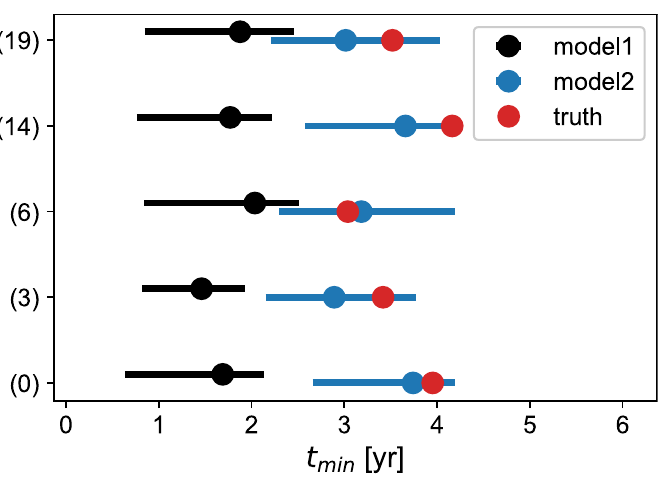
Fig 8. Monte-Carlo estimates of the regrowth time with an extra point at 1 year for the 5 outliers of Fig 7 ( t years). The black bars (model 1) corresponds to the 95% confidence-level intervals obtained from the standard constraint (Eq (8)) and the blue ones (model 2) with the loose constraint described in the text. The black/blue points corresponds to the mean values and the red point is the true value of each